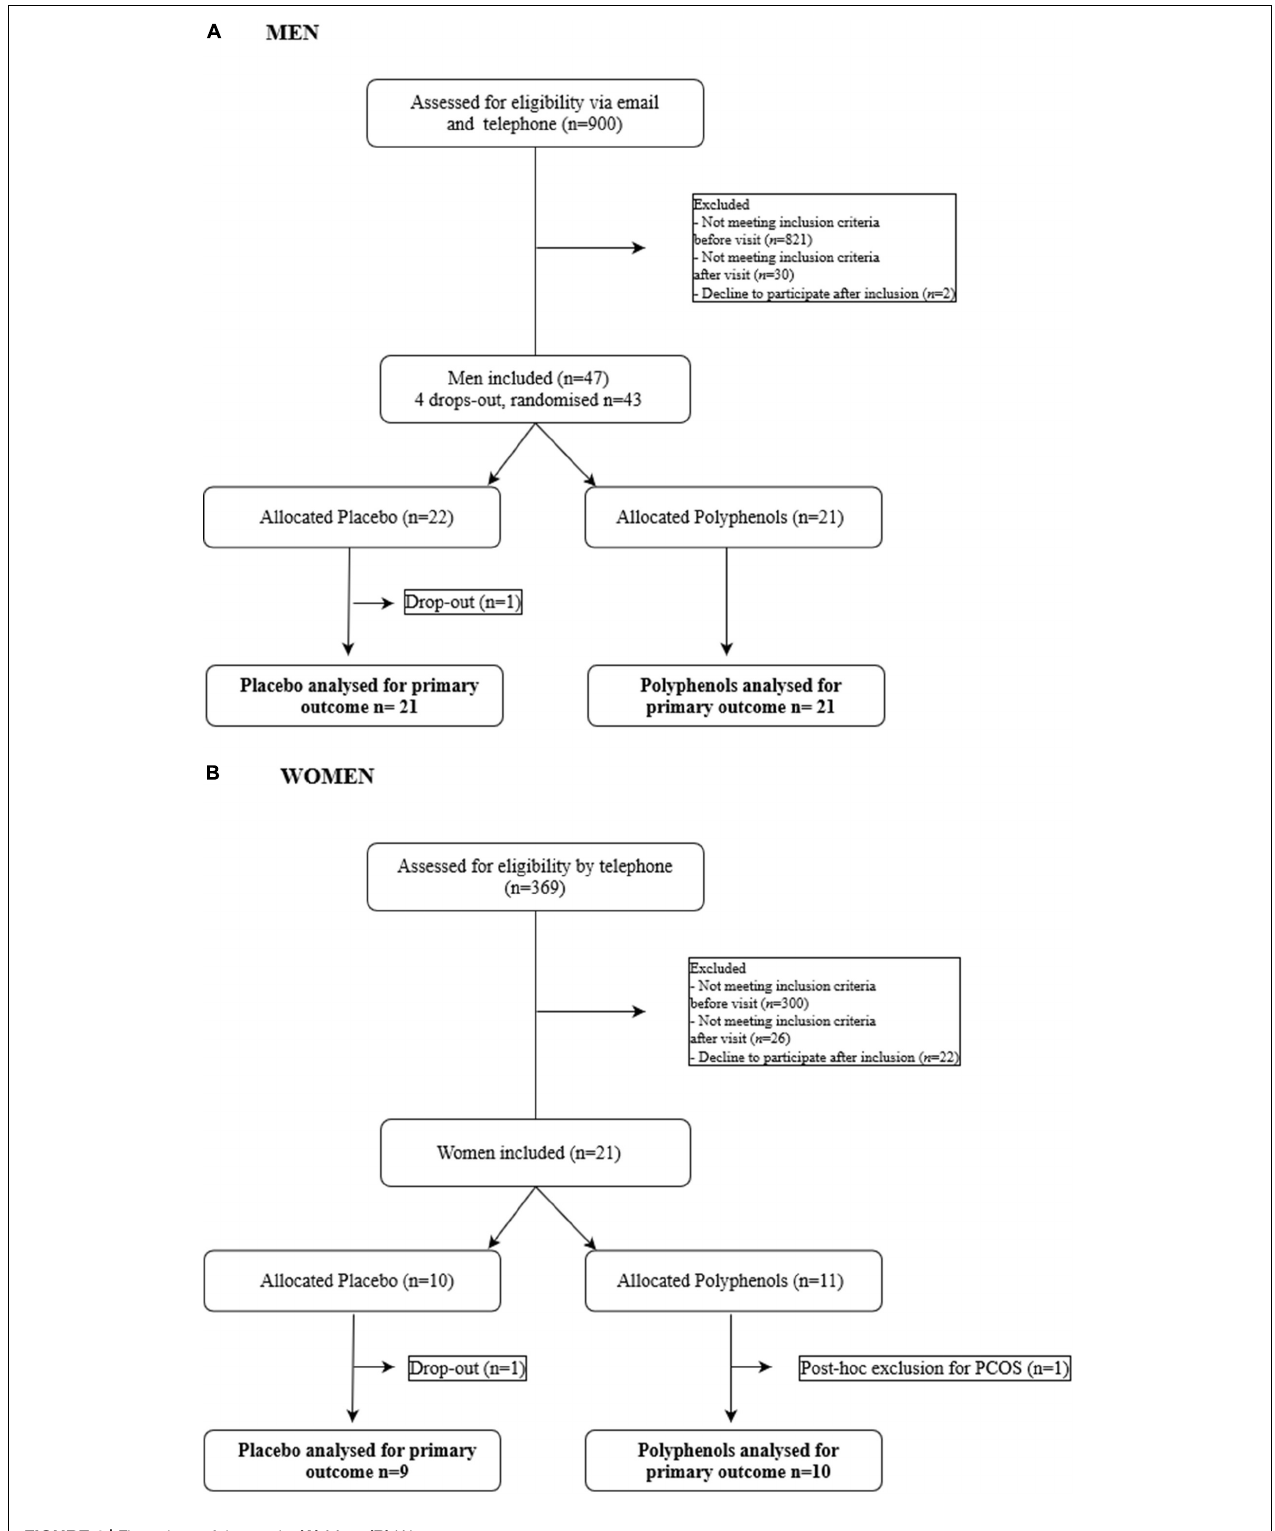
FIGURE 1 | Flow chart of the study. (A) Men. (B)